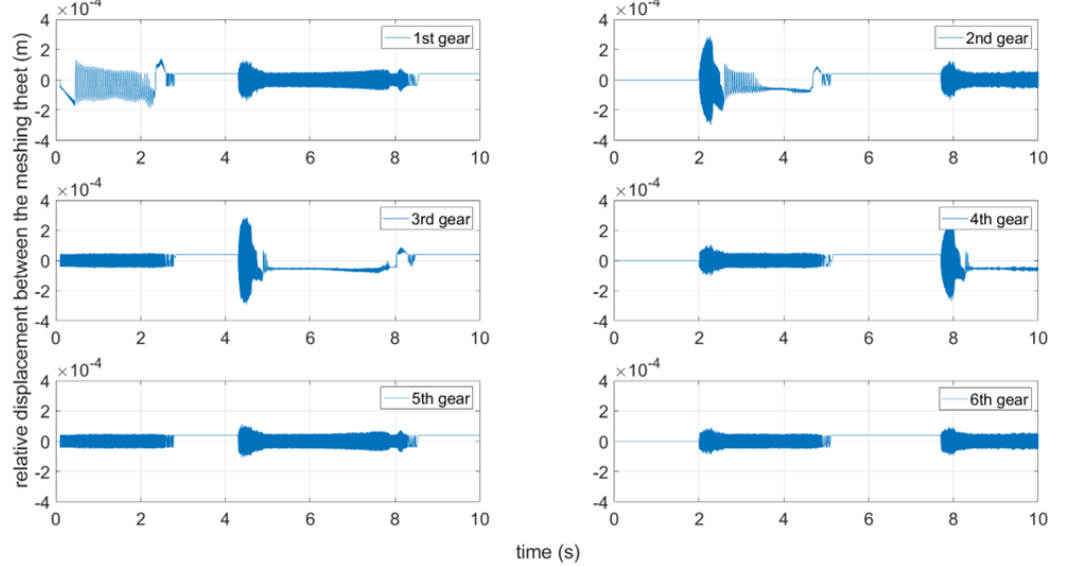
Figure 11. Angular relative motions of the various rattling gear pairs during a run-up transient: case (a).